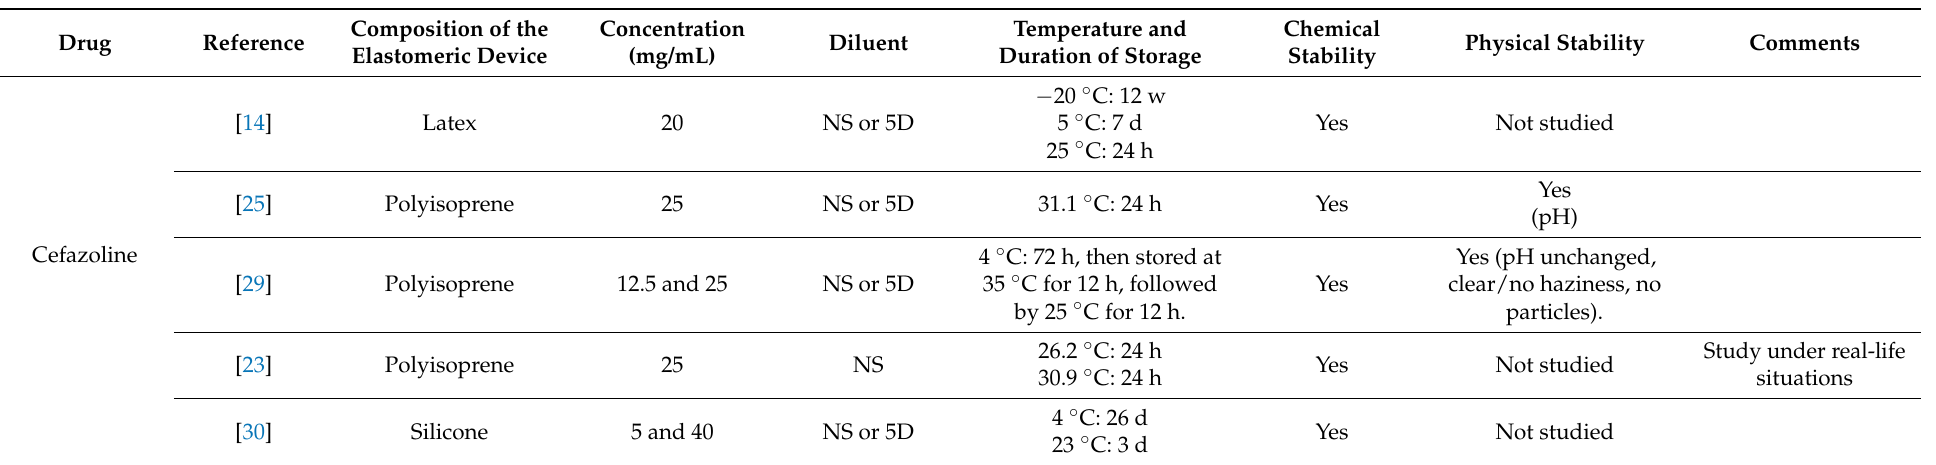
Table 2. Stability of cephalosporins in elastomeric